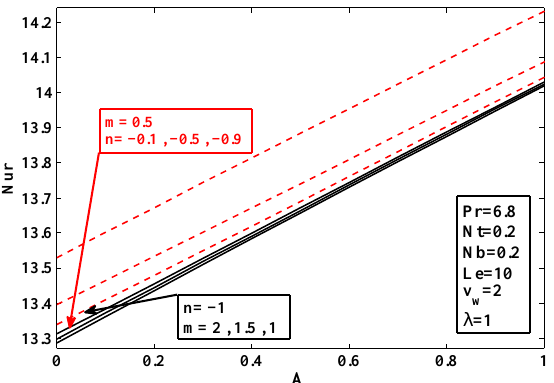
Figure 16: Effect of first-order slip parameter m and second-order slip parameter n on the reduced Nusselt number Nur .